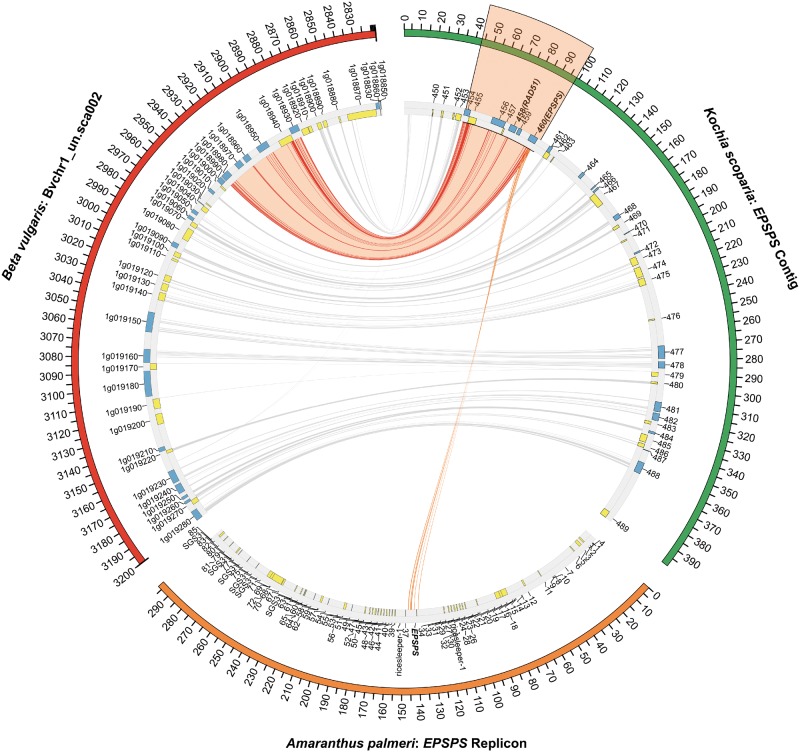
—A comparison of the EPSPS contig from kochia (Green), an genomic scaffold from chromosome 1 of the Beta vulgaris genome (Red) (GenBank ID: KQ090199.1) (Dohm et al. 2014), and the EPSPS replicon from Amaranthus palmeri (Orange) (Molin et al. 2017). Blue and yellow blocks indicate genes in the forward and reverse orientation, respectively. The EPSPS gene is highlighted in orange. Red, connecting lines, indicate areas of high similarity between Beta vulgaris and kochia. Orange, connecting lines indicate areas of high similarity between A. palmeri and kochia. Number of base pairs in the alignment is listed on the outside track. The links between Beta vulgaris and kochia that fall within the EPSPS-duplicated region are highlighted in orange.